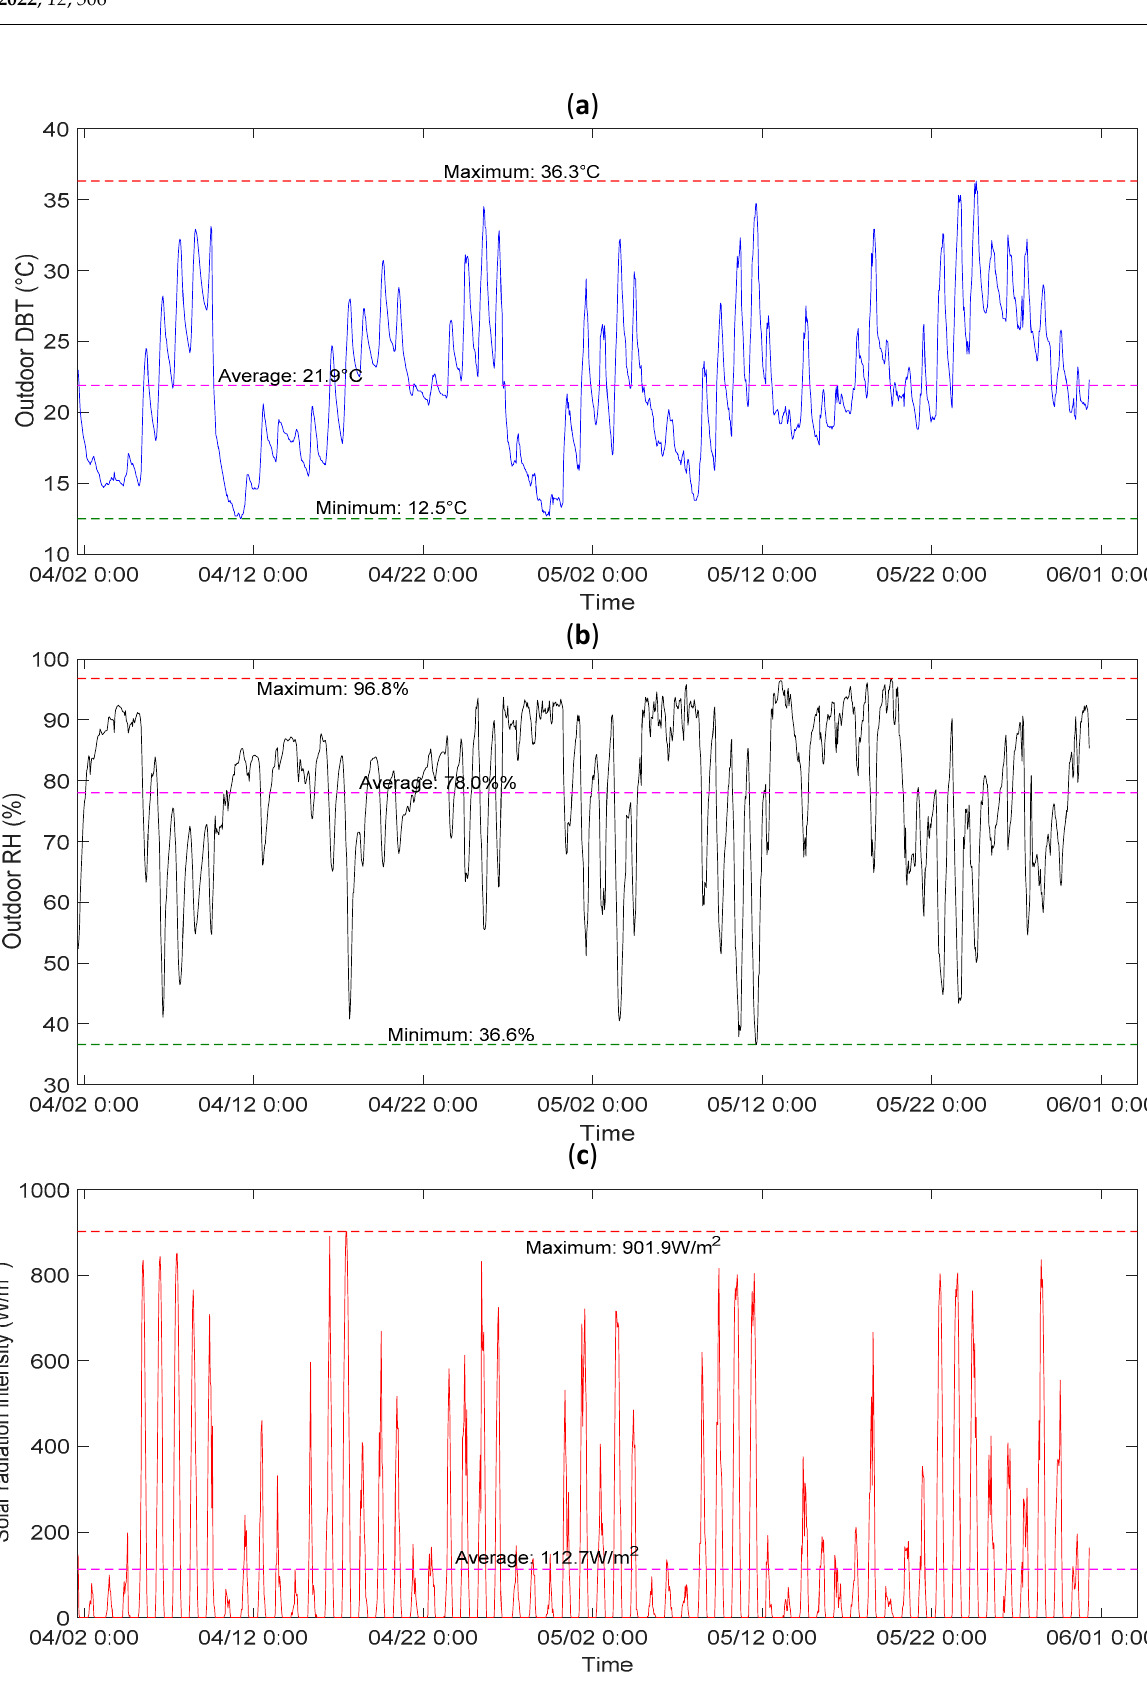
Figure 3. Outdoor DBT ( a ), RH ( b ), and solar radiation ( c ) values during the experiment.